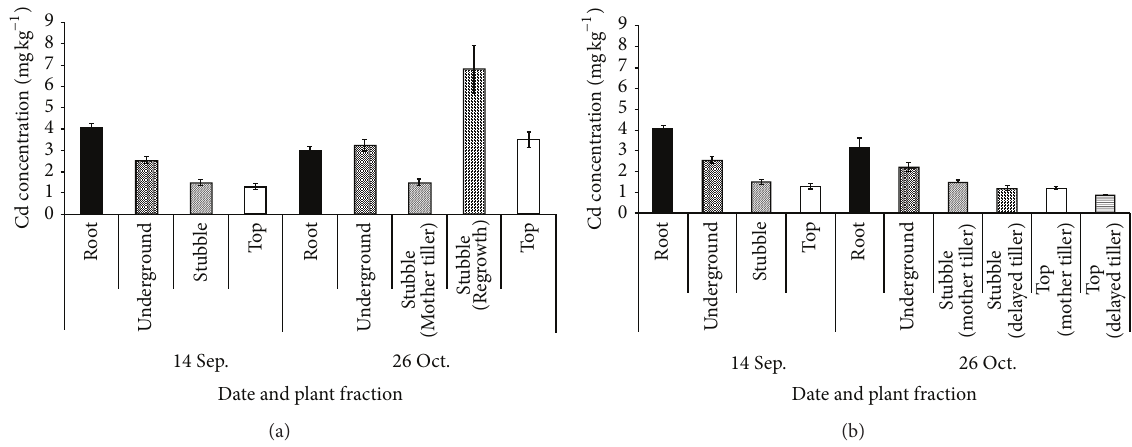
Figure 3: Cadmium (Cd) concentration in several plant fractions of Napiergrass after two cuttings (a) and after a single cutting (b). Mean ± standard deviation ( 𝑛 = 3